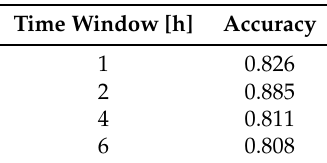
Table 3. Classification accuracy for the benchmark SVM